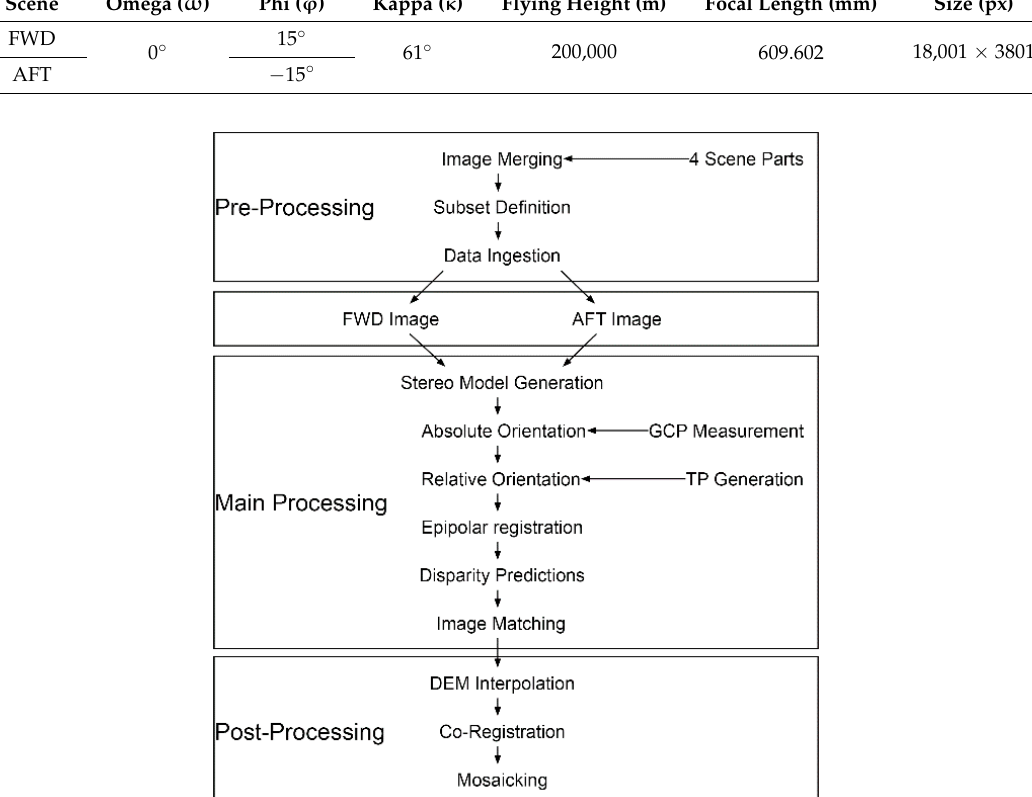
Table 4. Geometric parameter adjustment results for relative orientation. x, parallax across flight direction; y, parallax in flight direction.